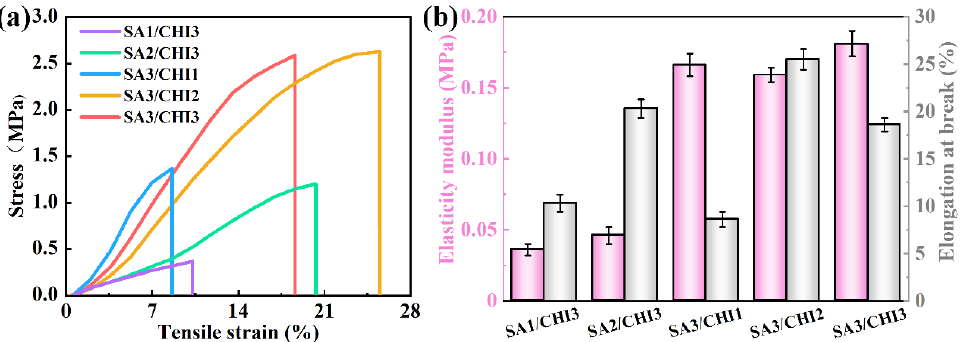
Figure 6. ( a ) Tensile stress/strain curves for various samples. ( b ) Test results of elasticity modulus and elongation at break for various